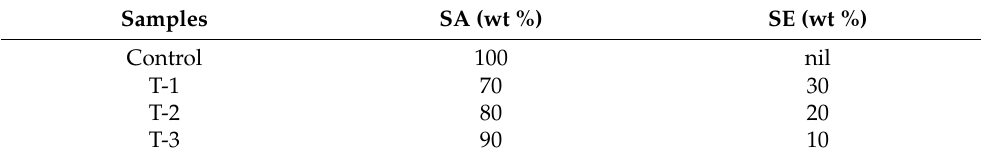
Table 2. Sample concentration of sodium alginate (SA) and Raphanus sativus L. seed extract (SE).